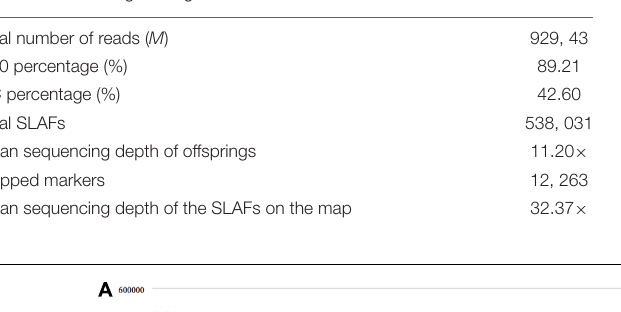
TABLE 1 | Summary of SLAF-seq results obtained using megagametophytes of 94 seeds from a single Ginkgo biloba tree.